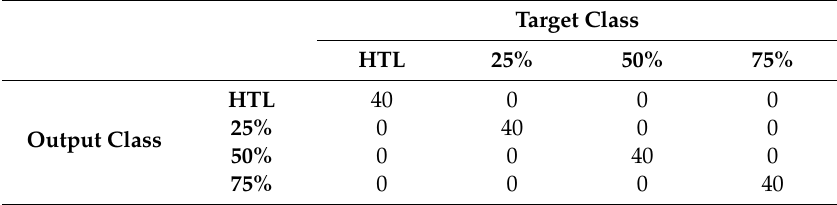
Table 3. Confusion matrix for the training of the ANN classifier with infrared imaging.